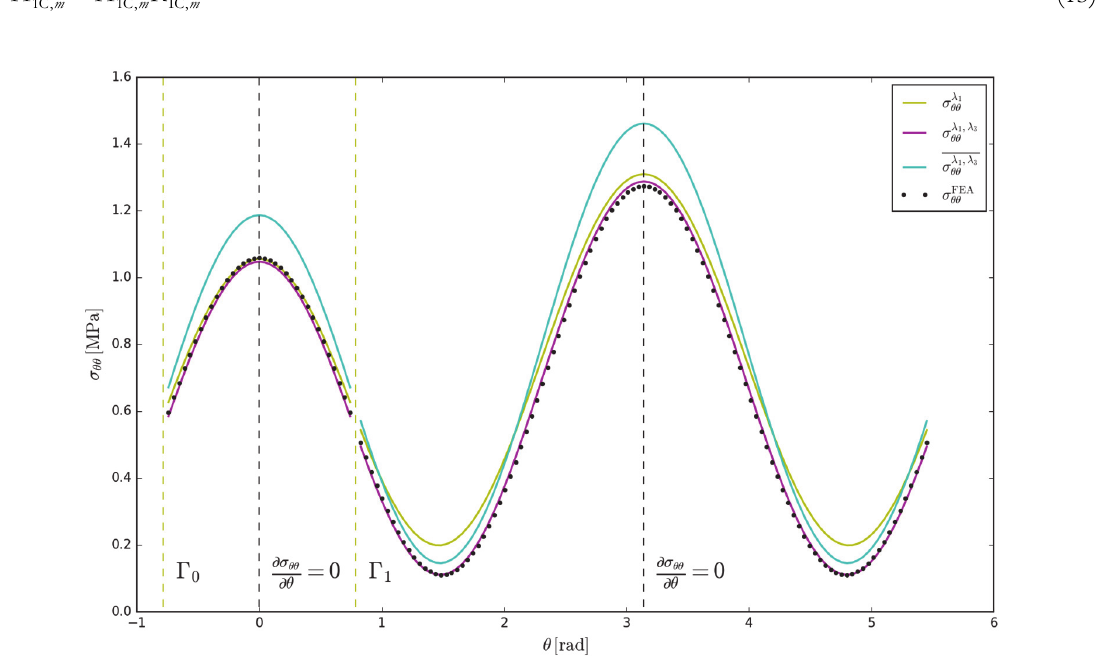
Figure 4: Tangential stress distribution for the case E 1 /E 2 = 0.5. Yellow and magenta curve stay for the analytical tangential stress solution on r = 1 mm obtained by one term H 1 and by two terms H 1 and H 3 respectively. The cyan curve is the mean tangential stress obtained by two terms H 1 and H 3 . Black dots represent the FEM solution on r = 1 mm. The yellow vertical lines denote the interfaces and black vertical lines the function local and global